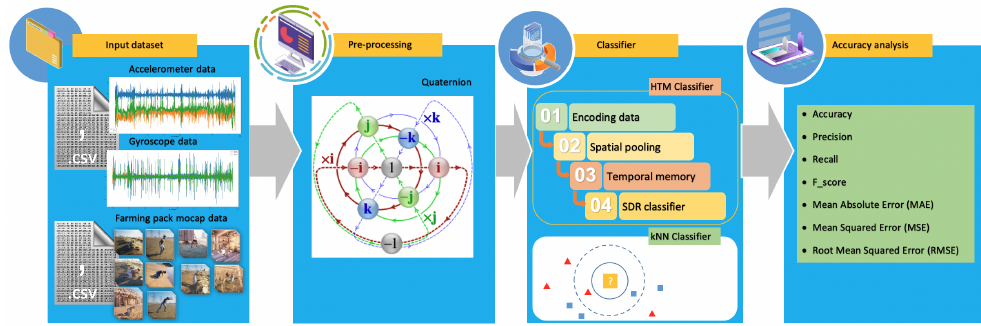
Figure 6. Proposed framework for prediction probability.